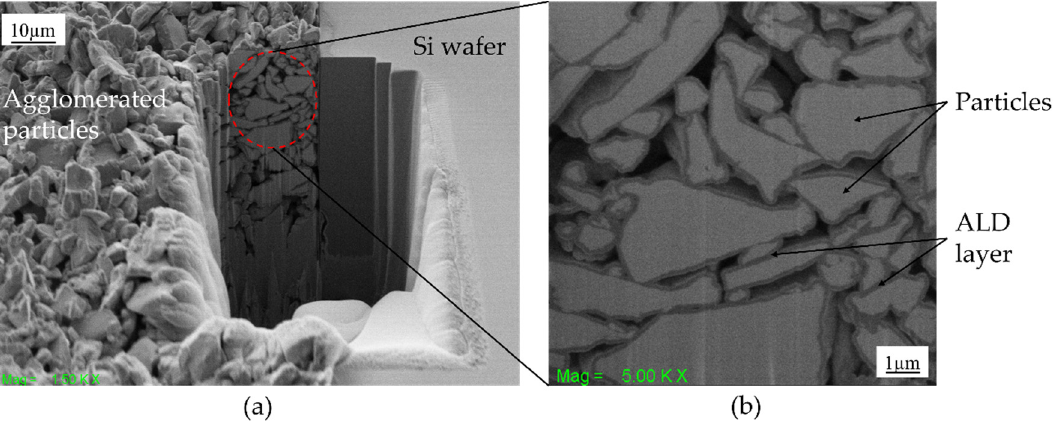
Figure 1. ( a , b ) FIB-SEM cross-sectional image of agglomerated particles after atomic layer deposition of aluminum oxide layer.